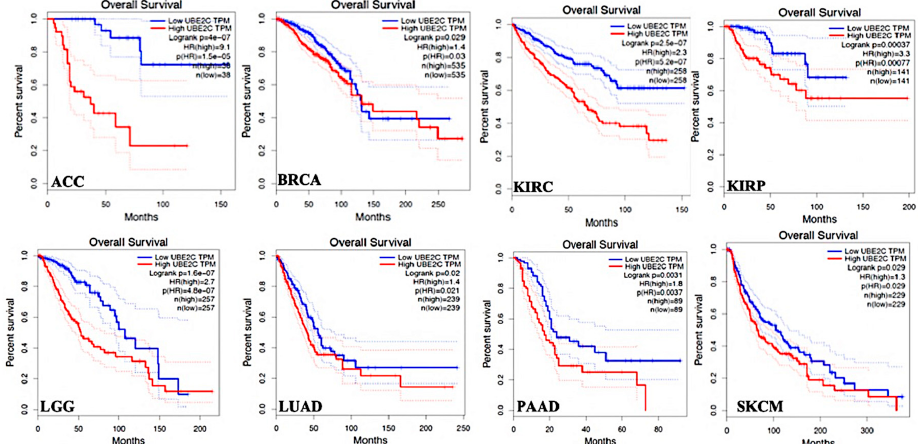
Figure 3. OS time between UBE2C higher-expression-level and UBE2C lower-expression-level tumors in TCGA tumor types with shorter overall survival time and worse OS prognosis. Red line shows the cases with highly expressed UBE2C and blue line is indicated for the cases with lowly expressed UBE2C . HR: hazard ratio.